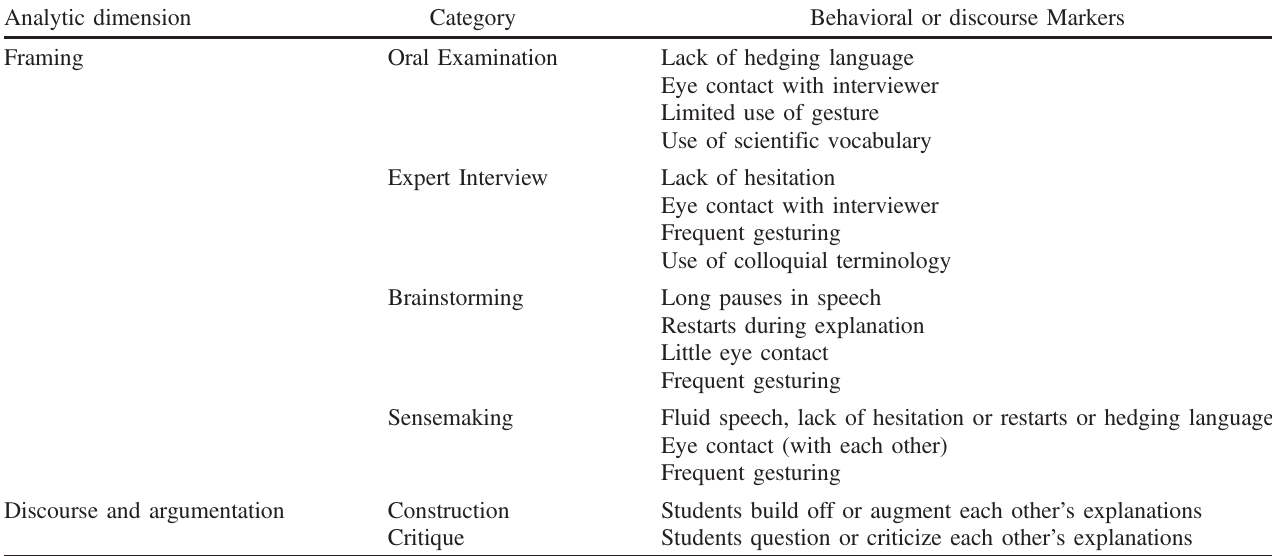
TABLE II. Analytic dimensions, categories, and behavioral or discourse markers used in analysis. Analytic